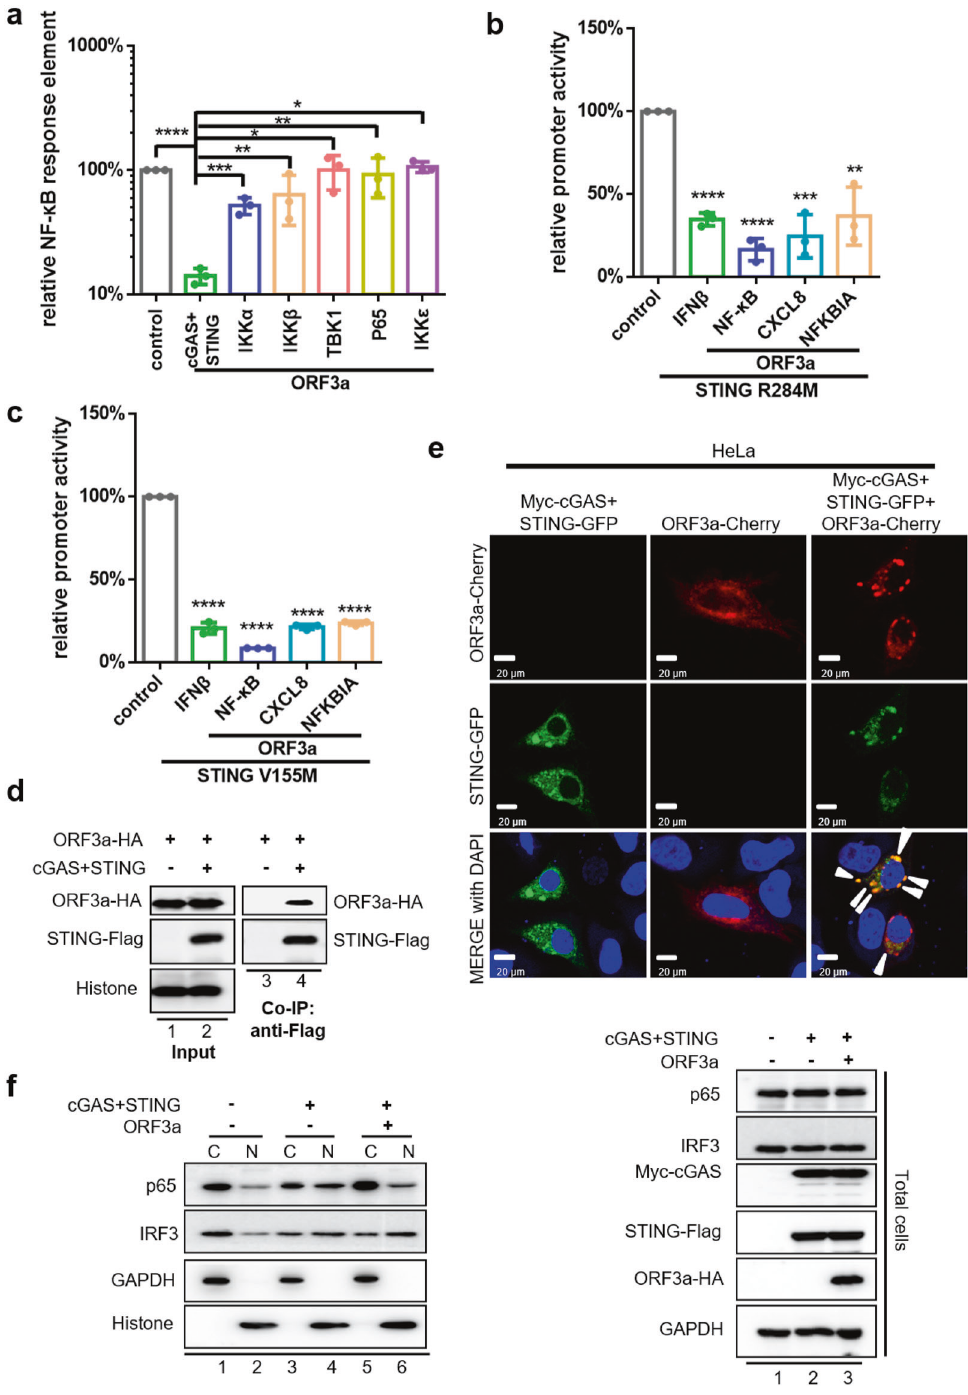
infection-induced mitochondrial damage. 19 – 21 Viral structural proteins and virion-associated accessory proteins of SARS-CoV-2 (Fig. 1a) are more likely to be involved in the suppression of host innate immune responses during the initial stages of viral infection. Using established experimental systems for the detec- tion of RLR- and cGAS-STING-triggered innate immune activa- tion, 22 – 24 we evaluated the innate immune modulation by various viral structural proteins, accessory proteins, and the main